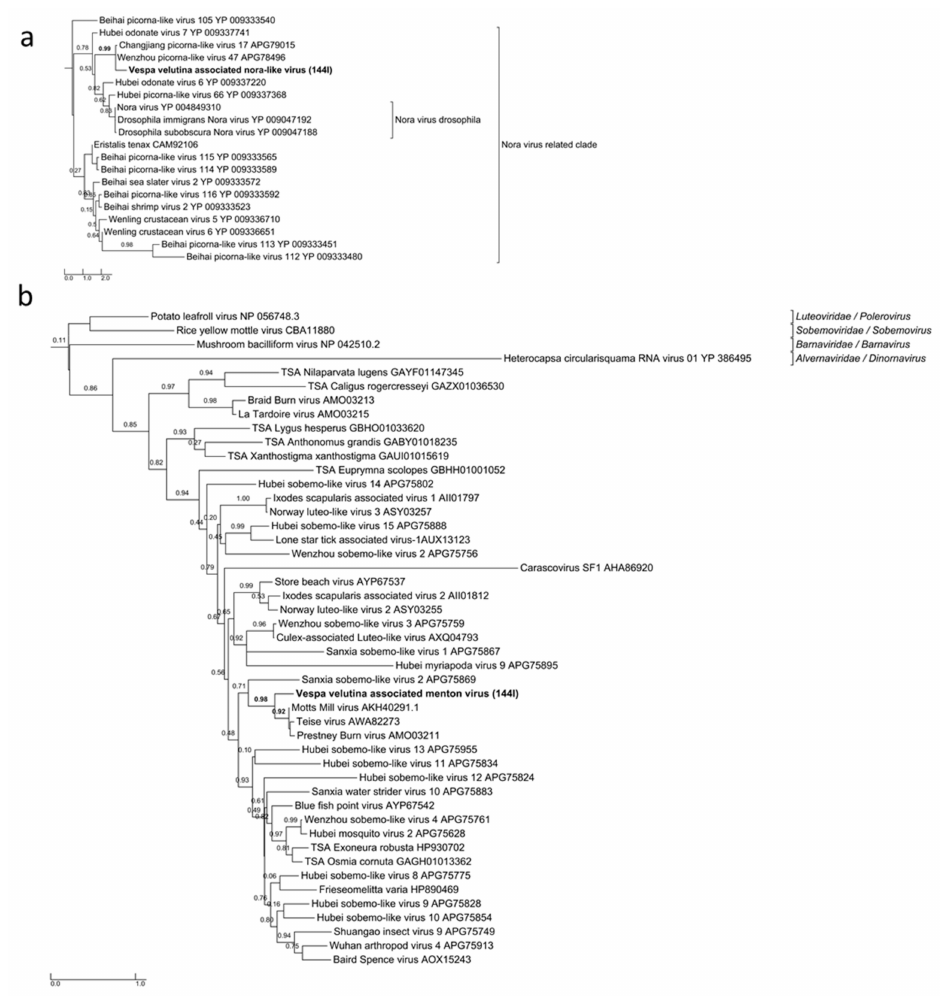
Figure 8. Maximum likelihood amino acid replicase phylogeny of ( a ) Vespa velutina associated nora-like virus (54 aa, LG + G model), ( b ) Vespa velutina associated Menton virus (162 aa, LG + G model). GenBank accessions are shown in Table